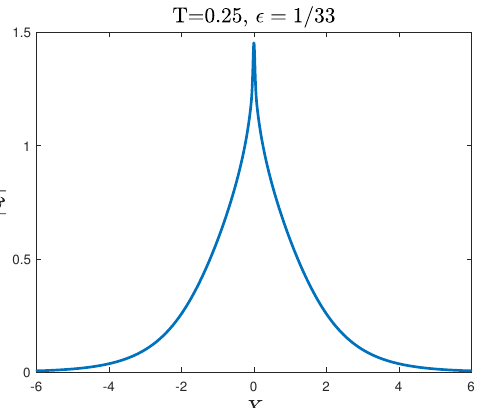
Figure 8. Case 3: The gradient catastrophe generated from the initial condition (13) when (cid:101) = 1/33, γ = 1, M = 1 and ∆ = 0.